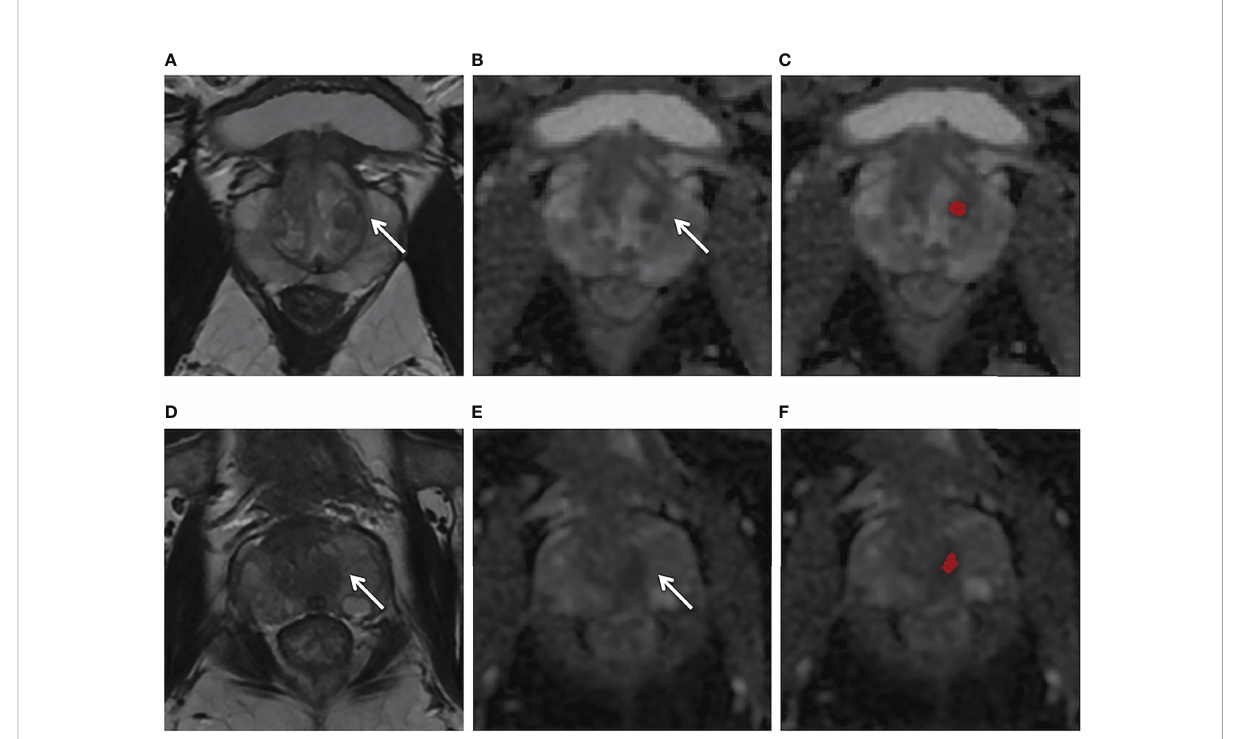
FIGURE 4 (A – C) Axial MR images obtained in a 56-year-old patient with a PSA level of 4.2 ng/ml and with negative biopsy fi ndings. T2WI (A) showed a heterogeneous encapsulated nodule in the left transition zone (arrow) and the ADC map (B) showed hypointensity (arrow). The ADC model (C) appeared false positive (red region). (D – F) Axial MR images obtained in a 64-year-old patient with a PSA level of 5.9 ng/ml and with negative biopsy fi ndings. T2W (D) and ADC (E) showed a normal left central zone, while the ADC model (F) appeared false positive in this area (red mark).